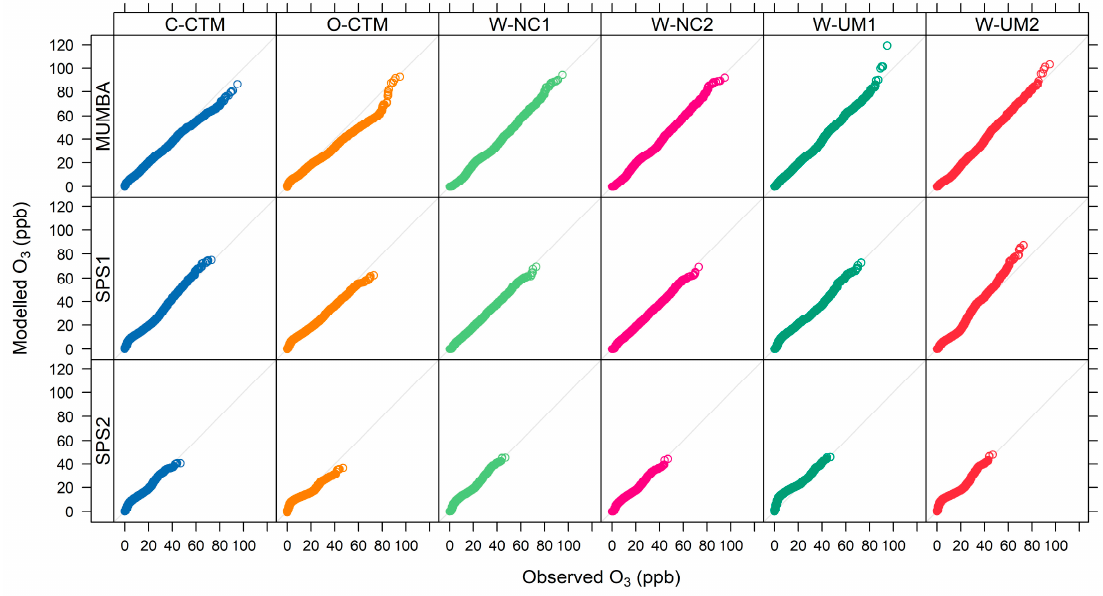
Figure 3. Quantile–quantile plot comparing modelled and observed hourly ozone distributions for each campaign. The x- and y- axes show ozone mixing ratios in ppb.